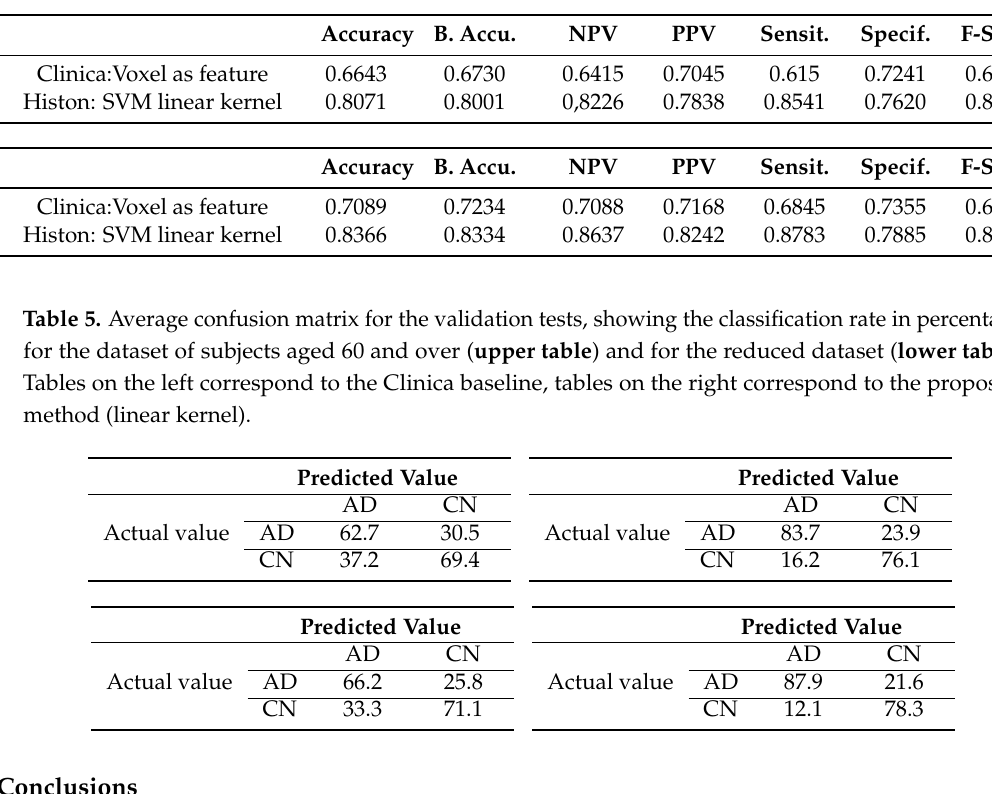
Table 4. Evaluation results showing a comparison between the mean evaluation metrics from the Clinica baseline and the method proposed (SVM trained using a linear kernel) for the dataset of subjects aged 60 and over ( upper table ) and for the reduced dataset ( lower table ).